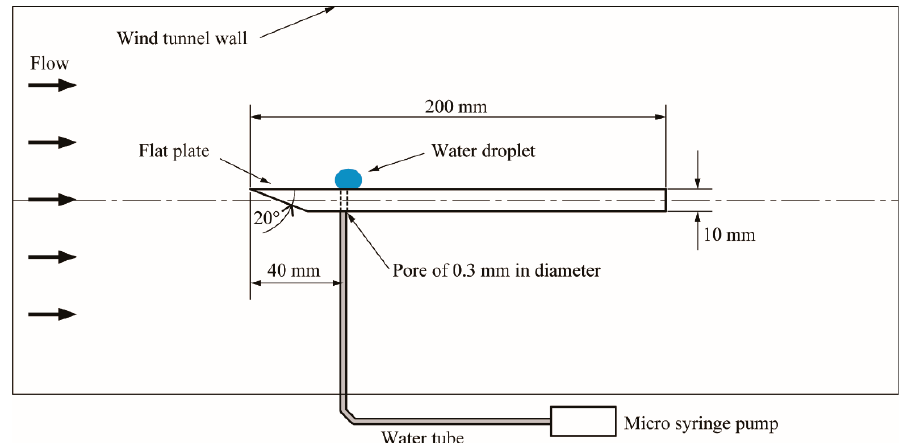
Figure 1. Schematic diagram of experimental setup. The flat plate was installed at the test section of the wind tunnel. Airflow can shed the pinned droplet over a superhydrophobic coating surface within a pore of 0.3 mm in diameter via a syringe pump.